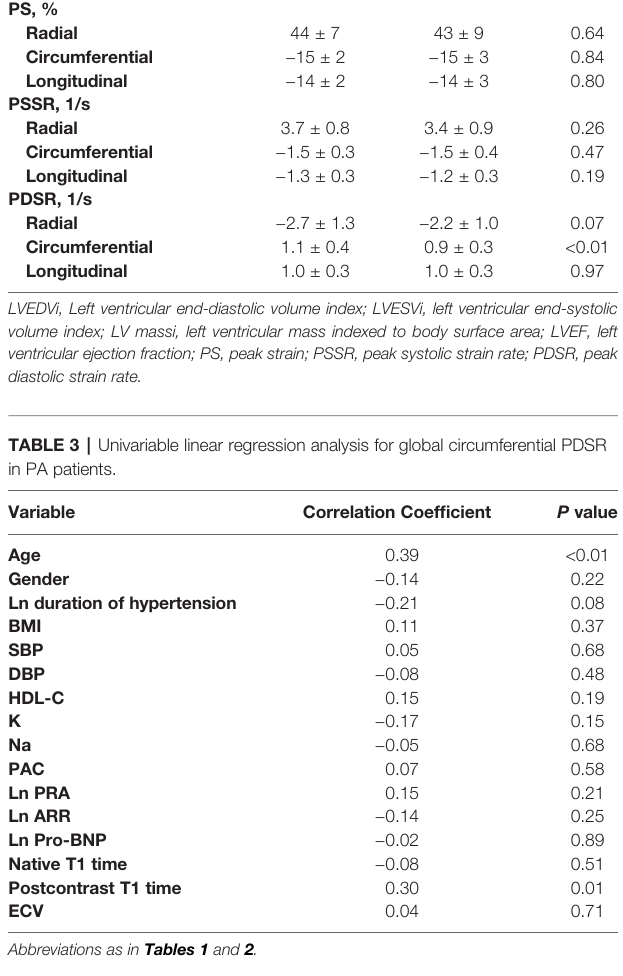
Table 5 . Correlation coef fi cient r were 0.749 – 0.957, p <0.001 for